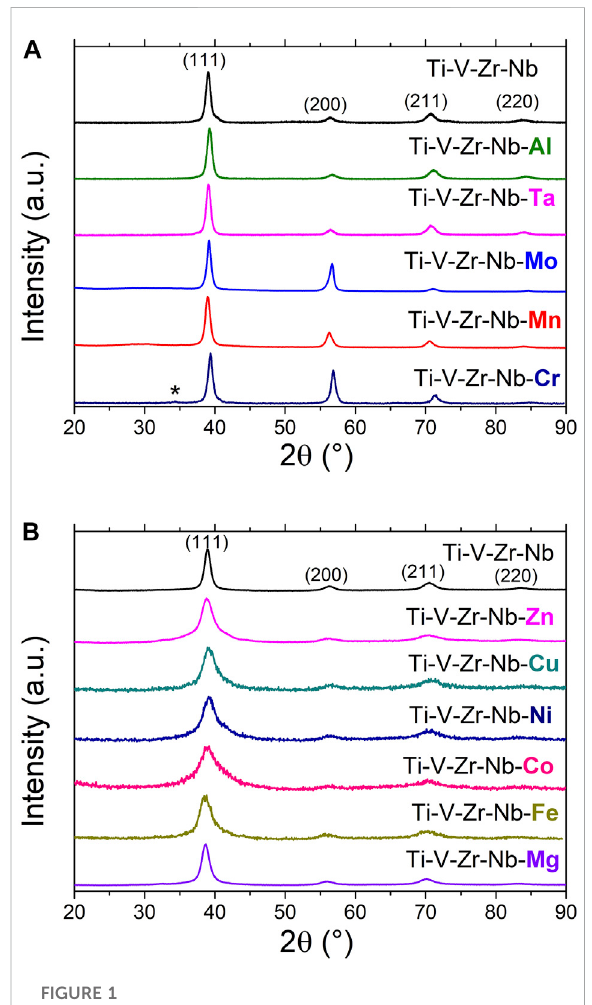
FIGURE 1 XRD patterns( λ = 1.5406 Å) of theTi 0.30 V 0.25 Zr 0.10 Nb 0.25 M 0.10 alloys prepared by arc melting (A) and ball milling under inert gas (B) . The diffraction patterns of the starting quaternary alloy (Ti-V-Zr-Nb) as prepared by both methods are also shown.